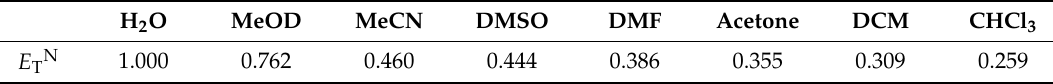
Table 3. Relative polarity of the used solvents [23].